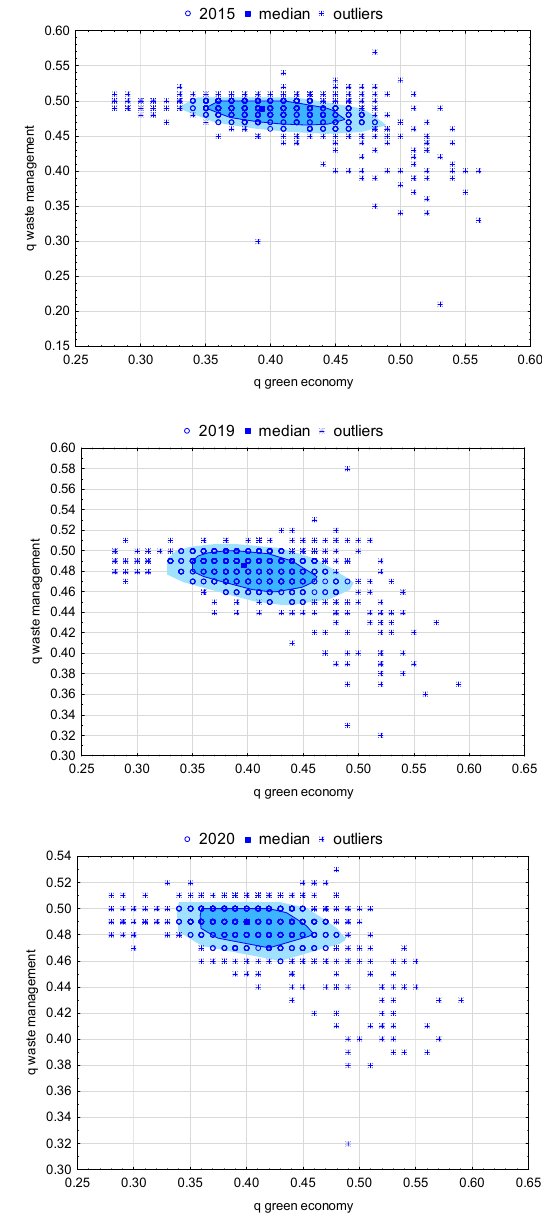
Figure 7. Spread of the synthetic measure of waste management in relation to the green economy of communes in Eastern Poland in 2010–2020. Source: own study.